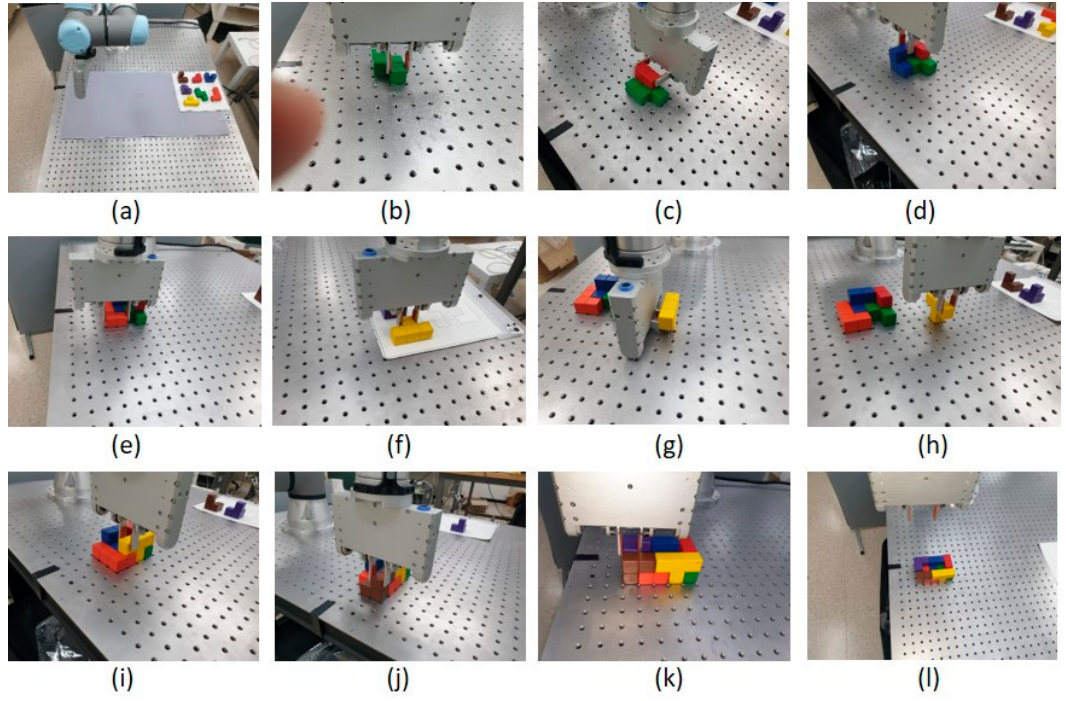
Figure 10. Soma puzzle assembly in formation 2 (shown in ( l )). From ( a – k ) the figures show the snapshots of the assembly poses of the gripper and part during the assembly process.